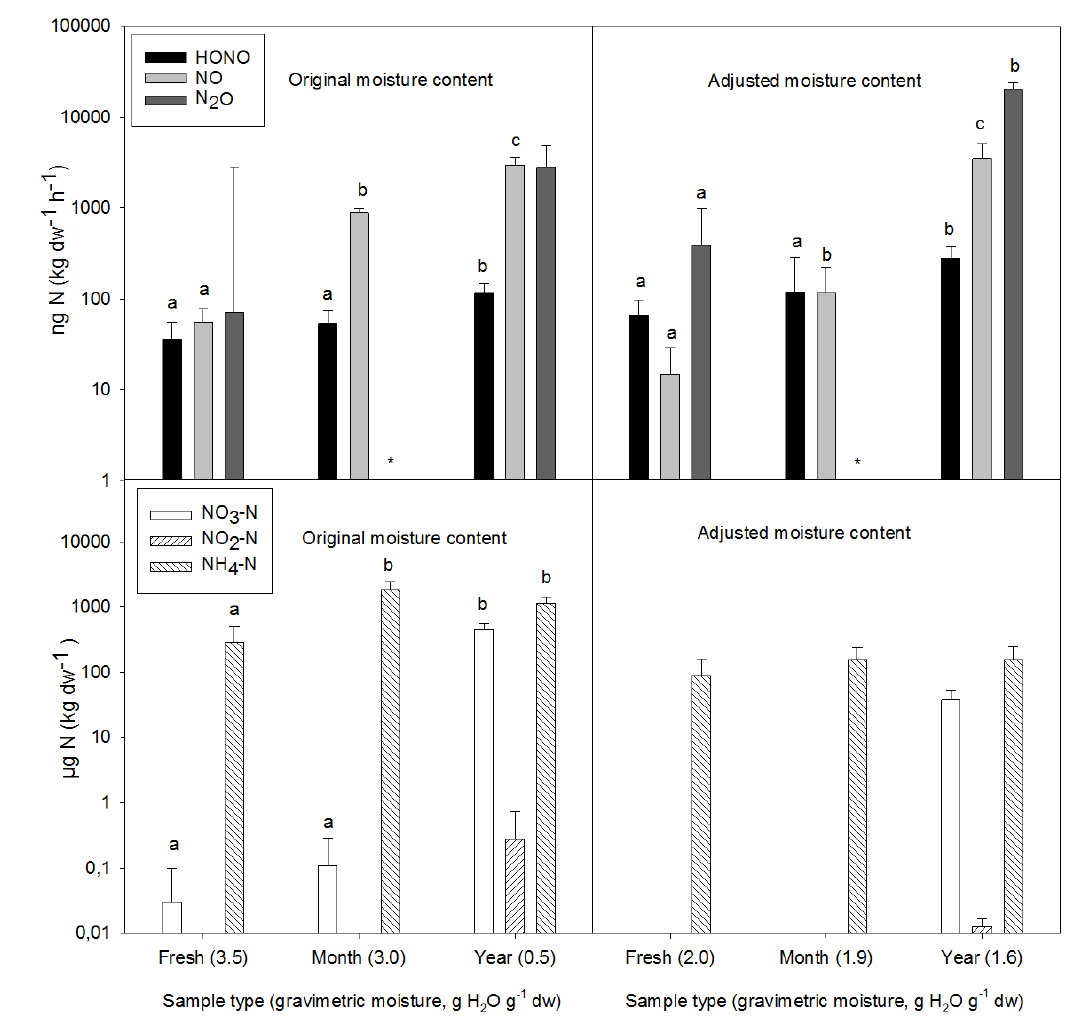
Fig. 1. HONO, NO and N O emissions and mineral nitrogen concentrations from samples in a) original 2 moisture content and b) adjusted moisture content. *) The average N negative (mean N O consumption rate 510 ± 330 and 350 ± 280 ng N kg dw -1 at original and adjusted 2 moisture) and therefore it is not shown in the figure with a log-scale on y-axis. Different letters indicate statistical difference between sample types (Mann Whitney